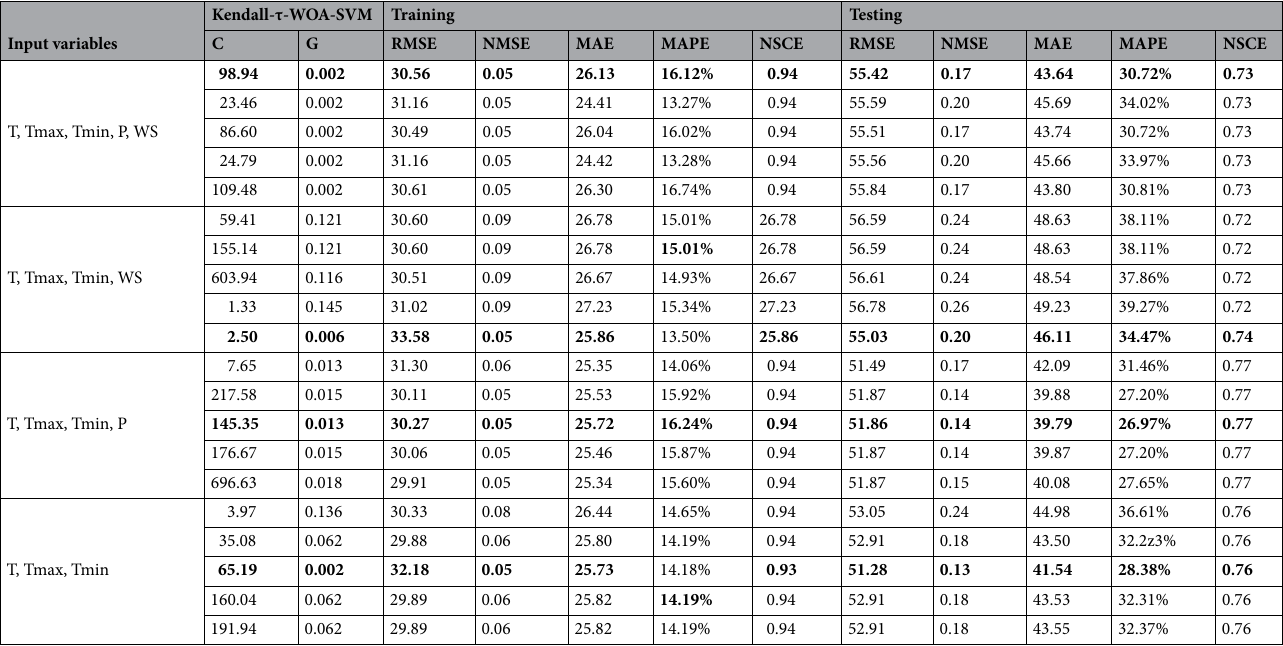
Table 6. The optimal hyper-parameters and model performance of Kendall-τ-WOA-SVM. The optimal hyper- parameters and evaluation metrics of the hybrid Kendall-τ-WOA-SVM model are marked in bold.